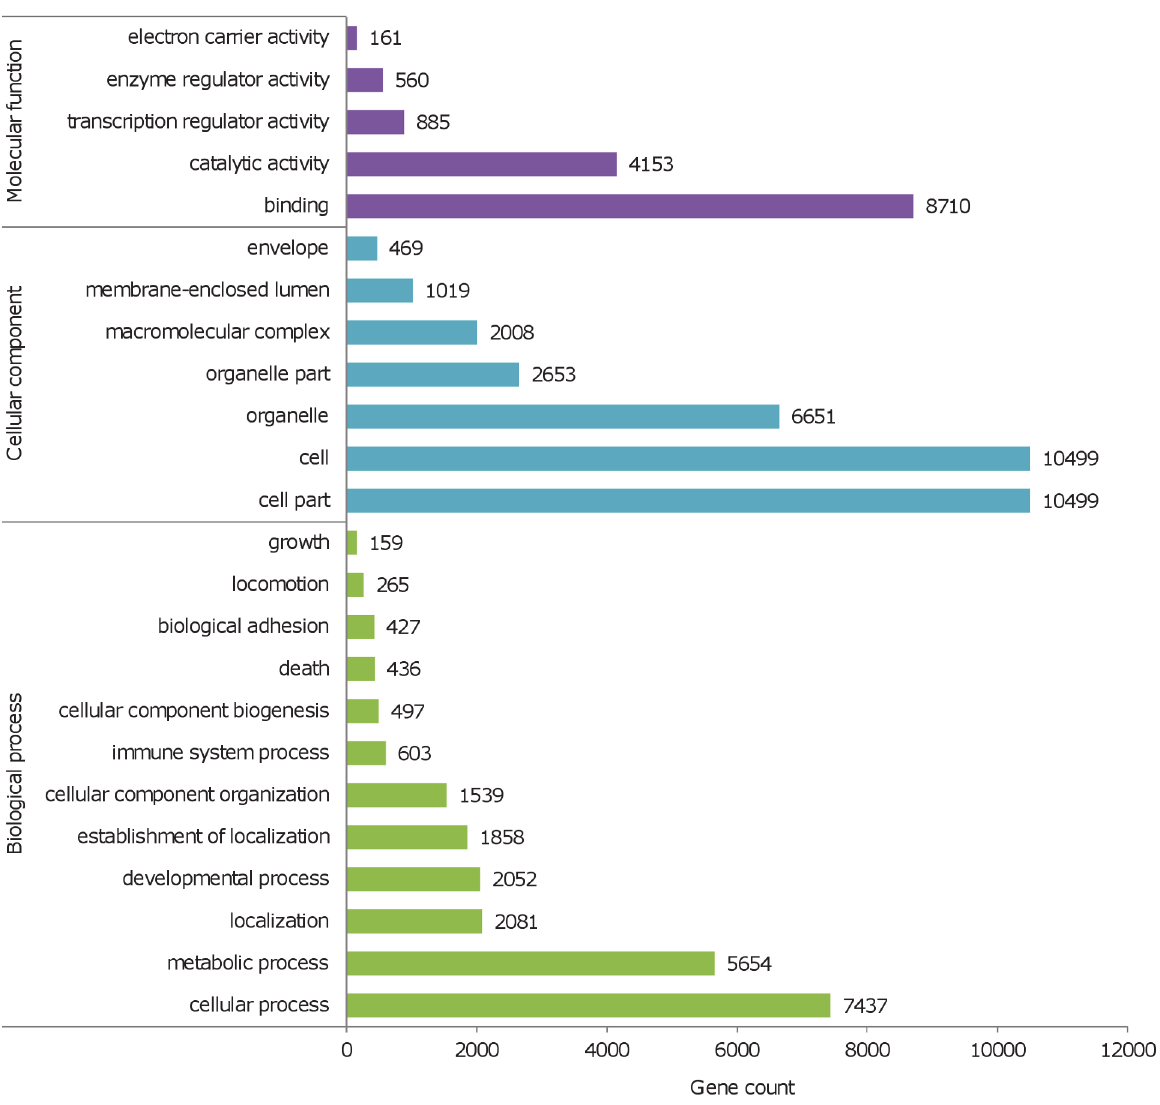
Fig 2. Functional annotation for the expressed renal genes of Abrothrix hirta reconstructed in a joint assembly of 16 individual transcriptomes. Gene abundance at the higher level terms of Gene Ontology, using DAVID [27] tools and databases, are shown for biological process (BP_FAT), cellular component (CC_FAT) and molecular function